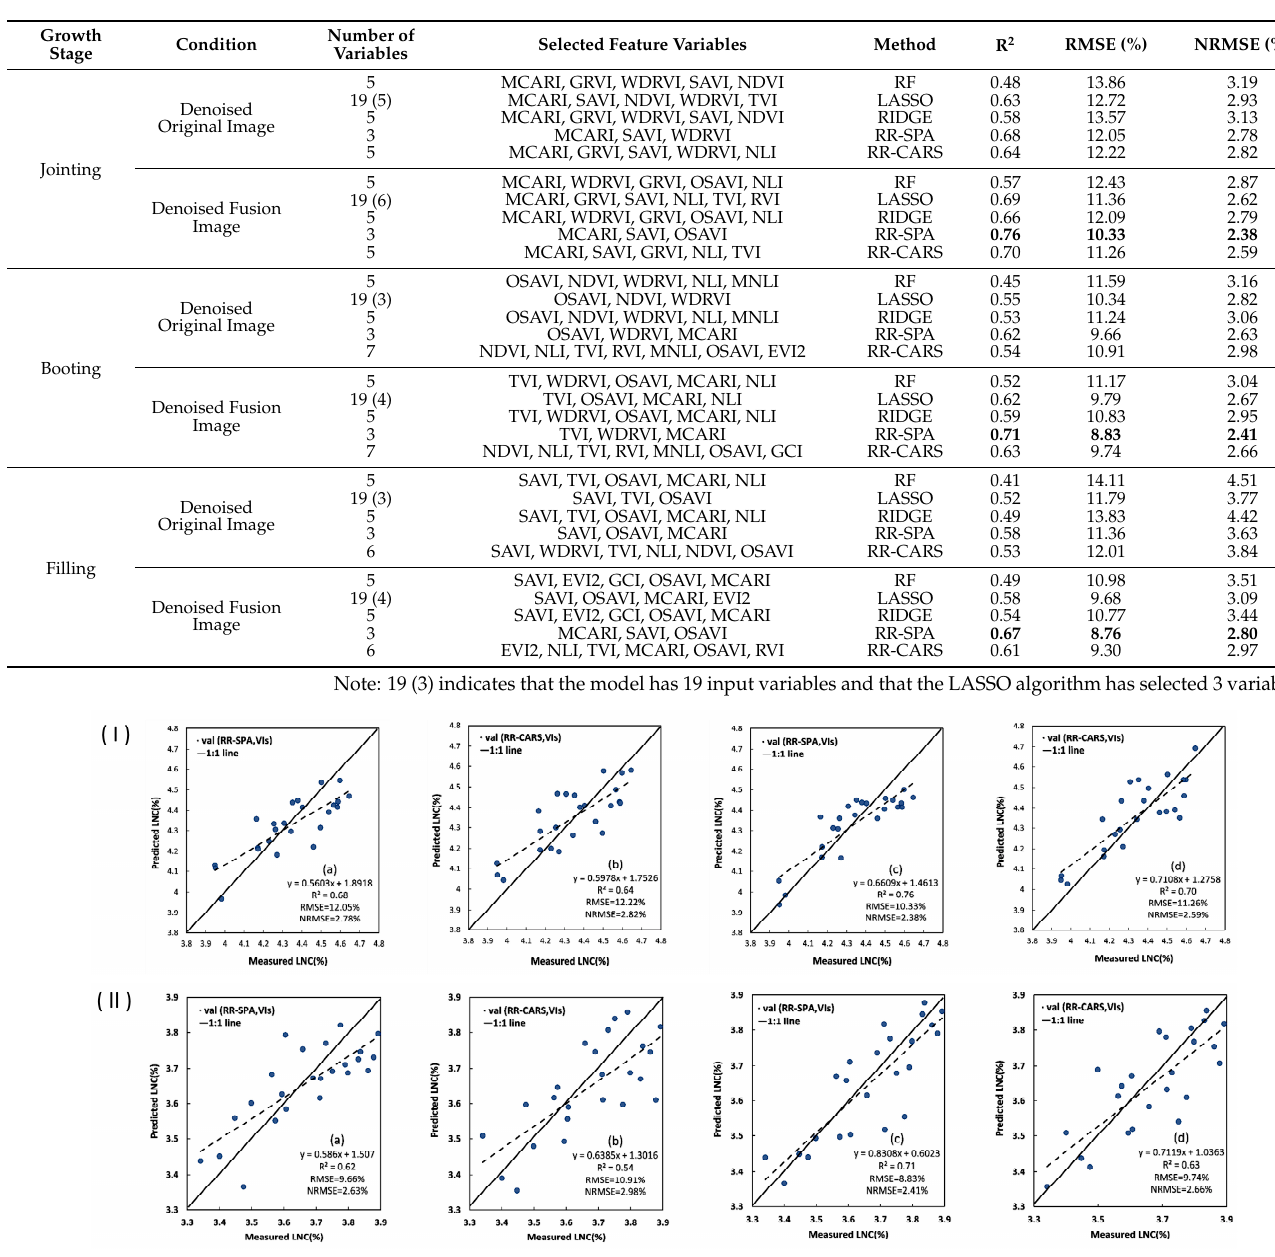
Table 6. Predictive performance of Rice LNC using the RF, LASSO, RIDGE, RR-SPA and RR-CARS algorithms for denoised original MS and fusion images.